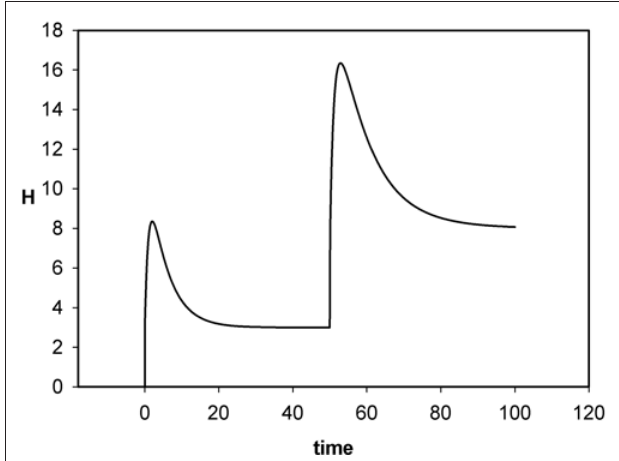
Figure 4 | Change of uncertainty, H , with time in a sensory system in response to two sequential stimuli. H (0) = 0. In response to a steady stimulus applied at t = 0, H rises rapidly, then adapts to a value of about 3 as uncertainty declines, but does not vanish. A second stimulus greater in magnitude than the first, is applied at t = 50. Uncertainty rises again, and then adapts to a value of about